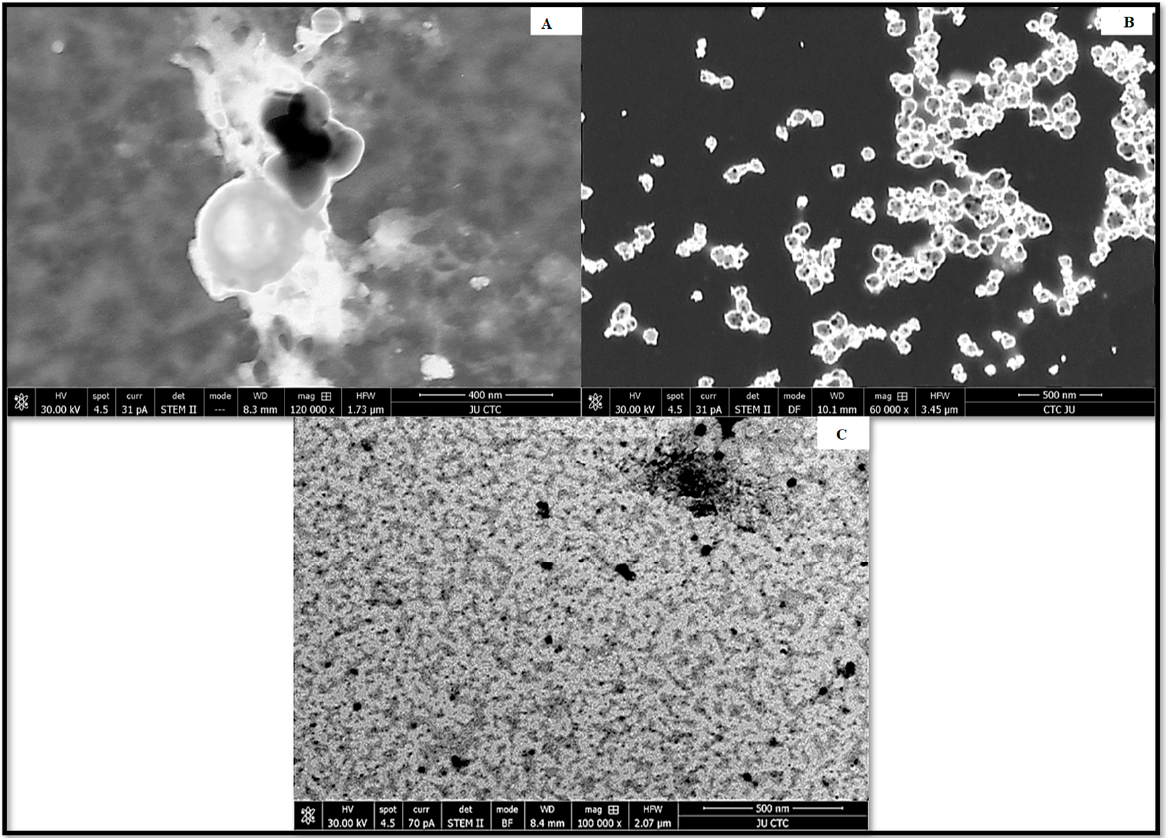
Figure 2. STEM micrograph of ( A ) biochar, ( B ) silver nanoparticles synthesized by the reaction of 1.0 mM silver nitrate with Emericella dentata filtrate and ( C ) combined AgNPs and biochar.